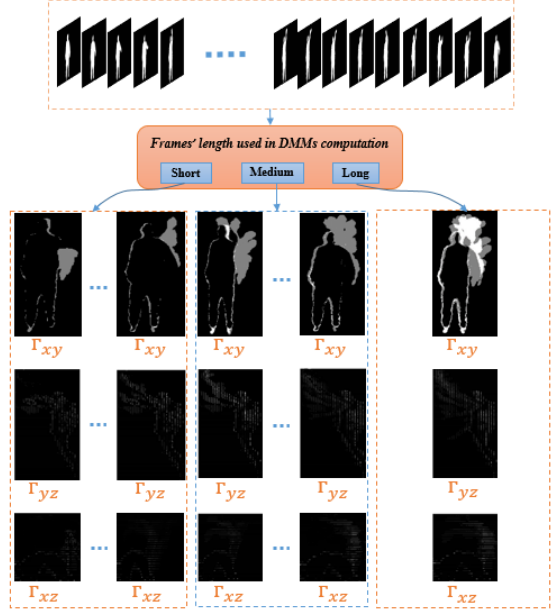
Figure 2. Computation procedure of the multi-resolution depth motion maps